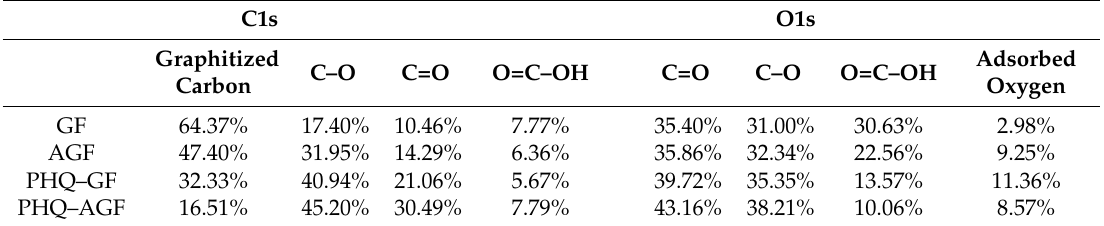
Table 1. Relative contents of functional groups deconvoluted from the C1s and O1s XPS peaks.